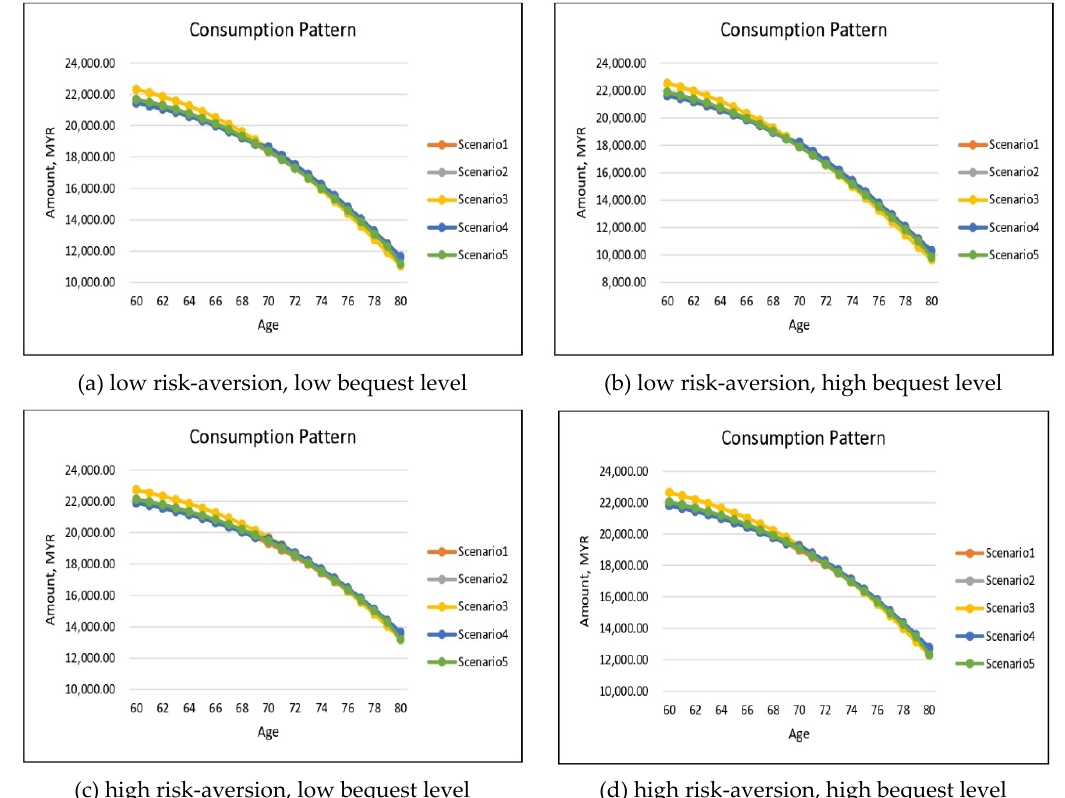
Figure 5. Optimal Consumption Pattern for Females (Health-Independent